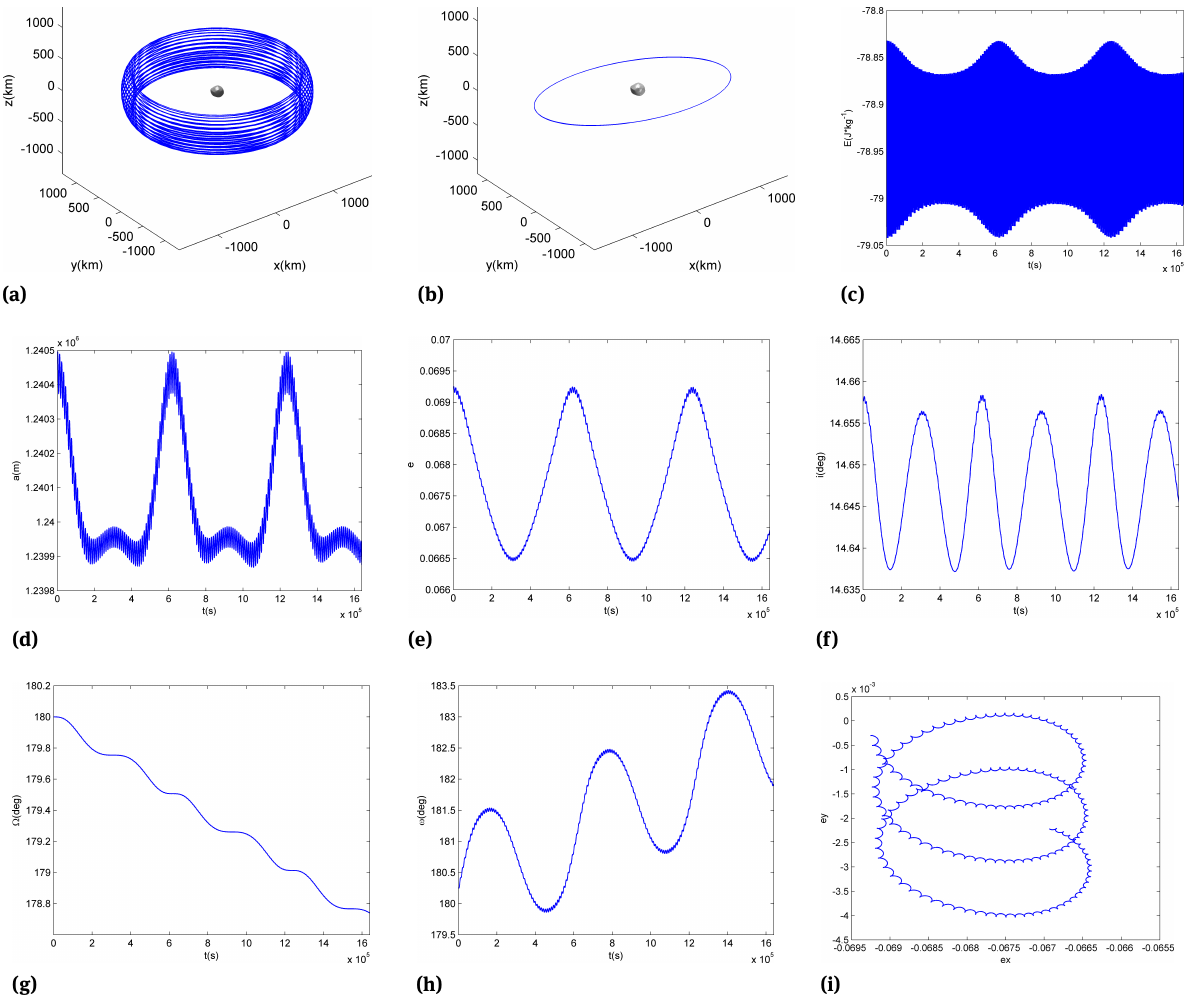
Figure 6. The second orbit in the gravitational potential of 45 Eugenia. (a) 3D plot of the orbit relative to the body-fixed coordinate system of principal axis of inertia; (b) 3D plot of the orbit relative to the inertia coordinate system; (c) Mechanical energy for the orbit; (d) Semi-major axis; (e) Eccentricity; (f) Inclination in the inertia coordinate system; (g) Longitude of the ascending node in the inertia coordinate system; (h) Argument of periapsis in the inertia coordinate system; (i) Eccentricity vector, e x = e cos( ω ) , e y = e sin( ω